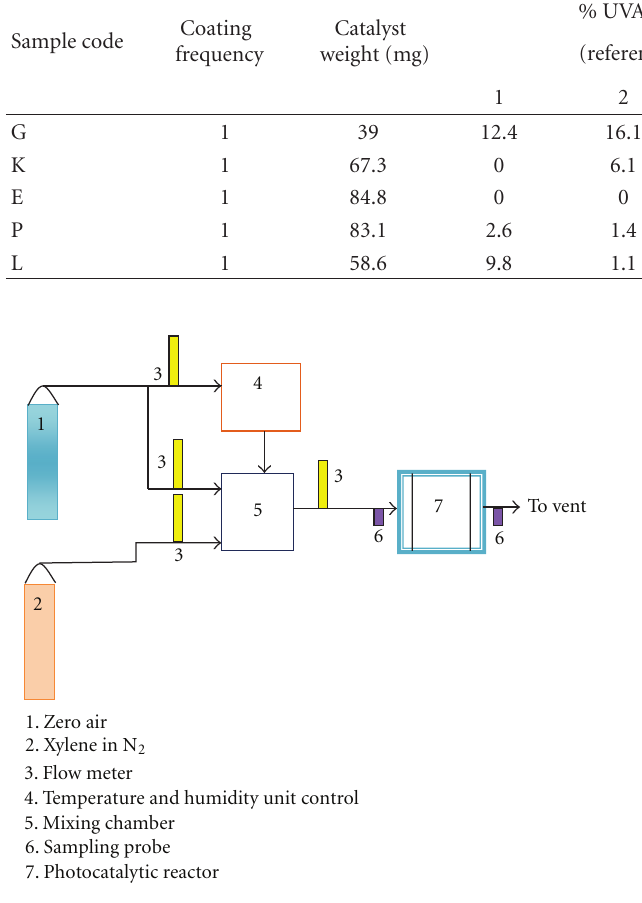
Figure 4: Schematic diagram of the photocatalytic activity test apparatus for the determination of xylene removal e ffi ciency for the samples prepared by the lowering, dip coating, and spraying techniques.